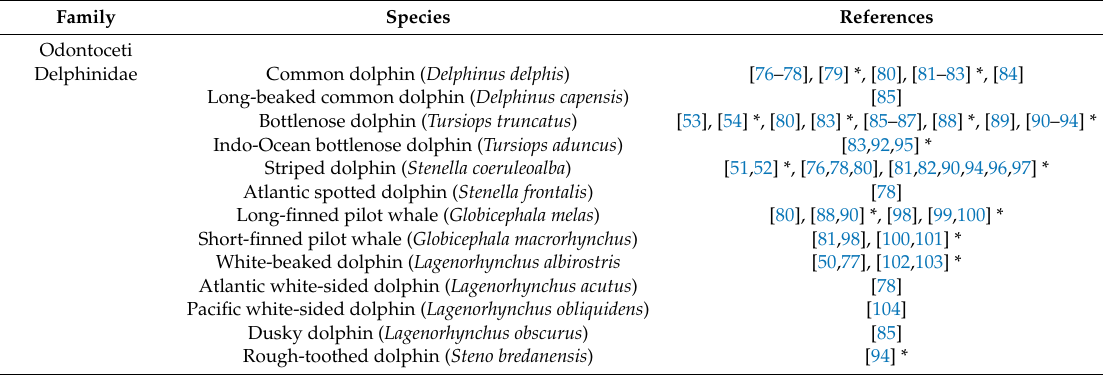
Table 2. Cetacean species infected with cetacean